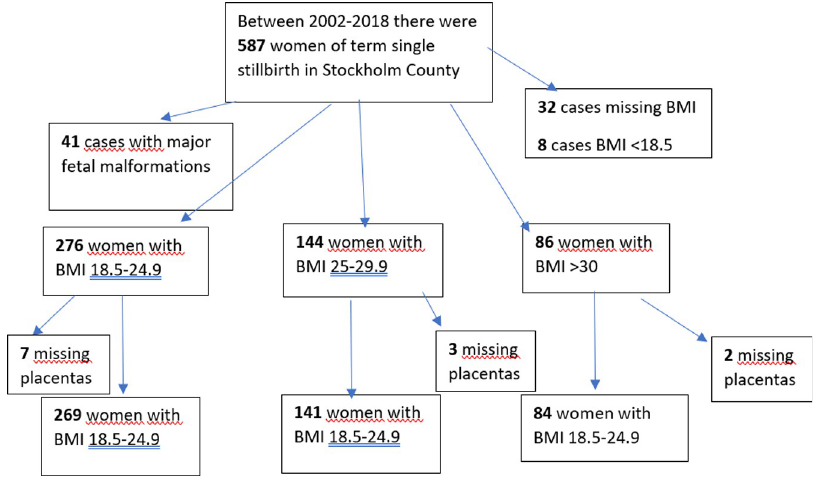
Fig 1. Flow-chart over number of cases.